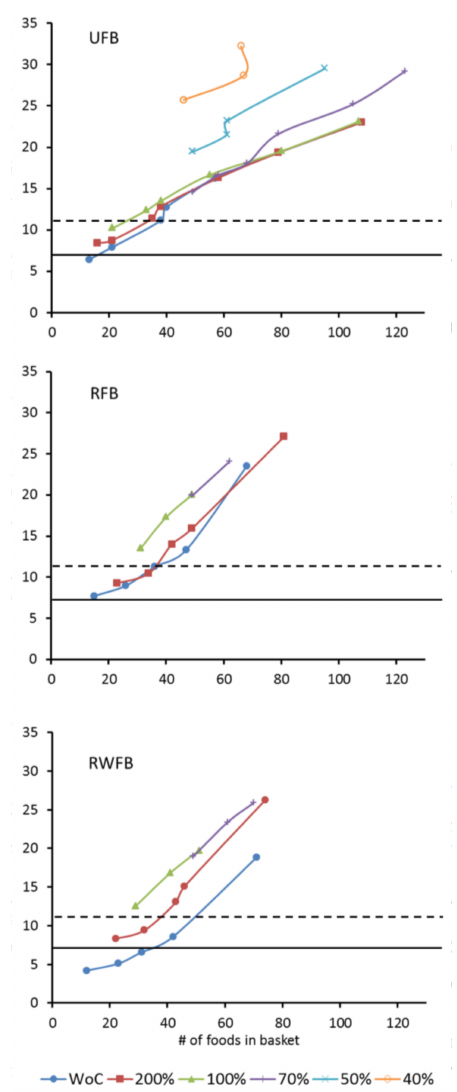
Figure 2. Correlation between cost and food diversity for single food baskets for a Ghanaian family of four. Charts refer to the UFB, the RFB and the RFB with wild foods included (RWFB). Each line represents a set of food baskets (FBs) that underlie the same maximum allowed contribution of a single food per category as described in the legend of Figure 1. The horizontal lines indicate threshold limits for poverty (USD 3.1, GHS 11.9, dashed) and extreme poverty (USD 1.9, GHS 7.3,